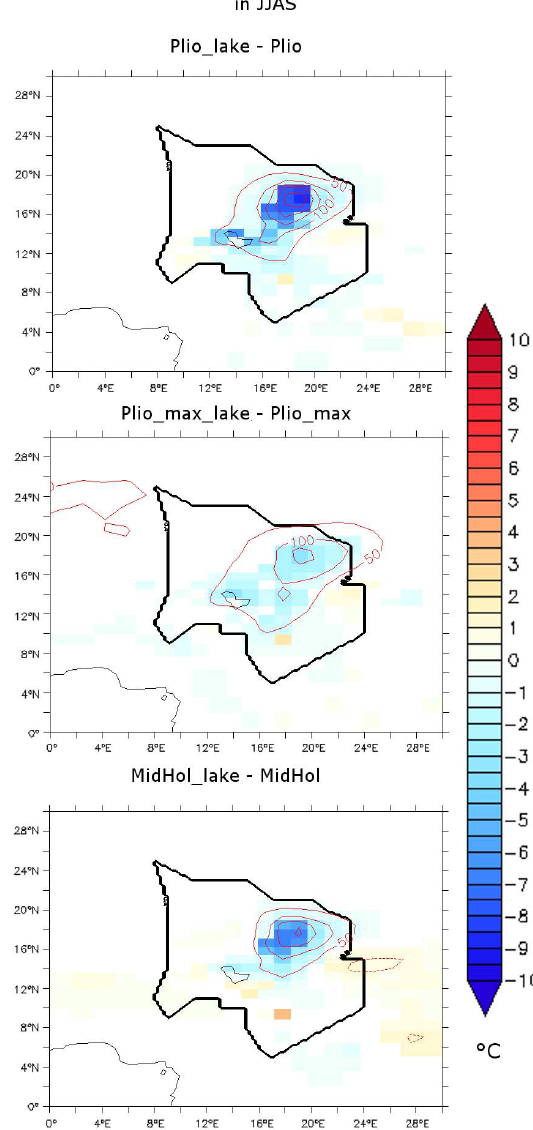
Fig. 7. JJAS surface temperature and sea level pressure (slp) differ- ence between “lake” experiment and standard experiment for each climatic configuration. Temperature difference is significant at 95% in a Student’s t test. Sea level pressure difference is expressed in Pa. Isolines every